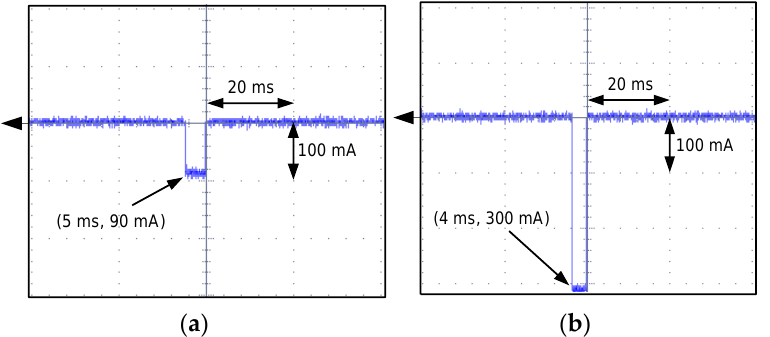
Figure 26. Oscillograms of the DC current flow during the tripping test of the A-type RCD (RCD30_8). Suddenly applied DC current of the following values: ( a ) 90 mA; ( b ) 300 mA.